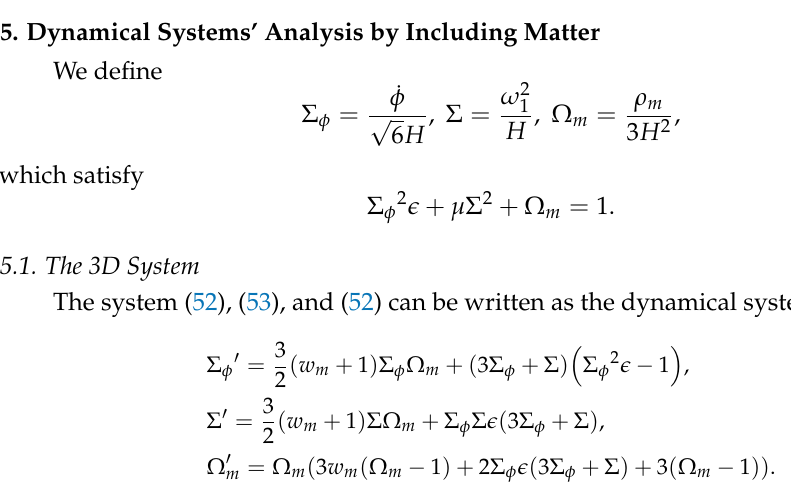
Figure 4. Phase plot for the reduced 1D equation (79) for (cid:101) = ± 1 and µ =